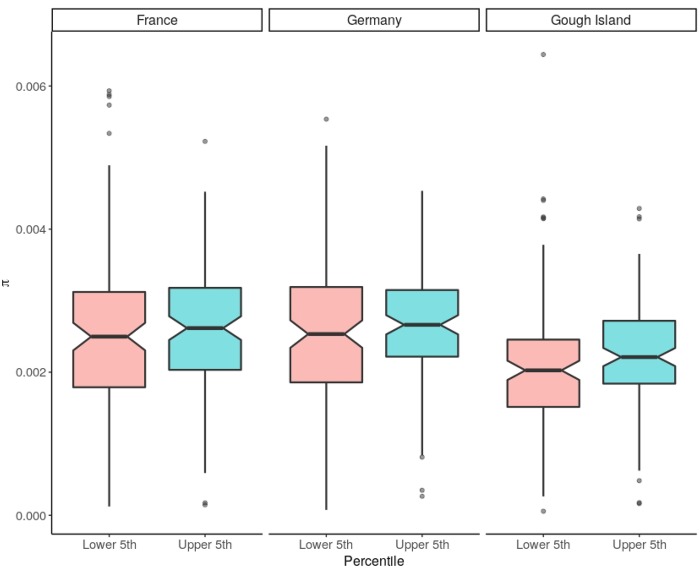
—Nucleotide diversity (θπ) in windows with recombination rates in either the lower or upper 5th percentiles of the genome-wide distribution. There is no significant difference in θπ between high-recombination rate and low-recombination rate windows for France (P = 0.510) or Germany (P = 0.200). There is a significant difference for Gough Island (P = 0.017) (Wilcoxon rank-sum test).